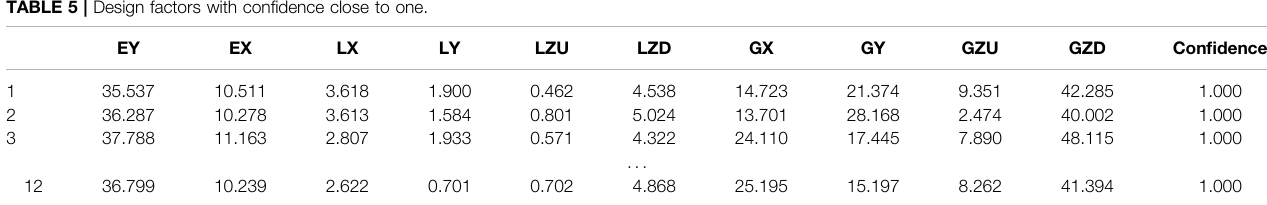
TABLE 5 | Design factors with con fi dence close to one.